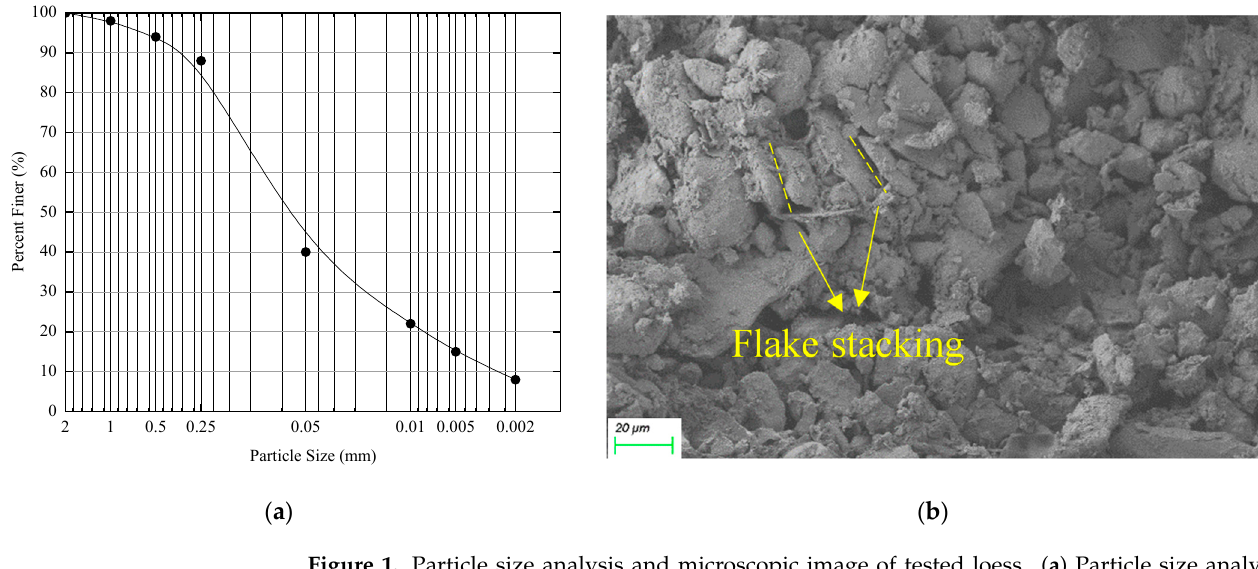
Figure 1. Particle size analysis and microscopic image of tested loess. ( a ) Particle size analysis, ( b ) Microscopic image.